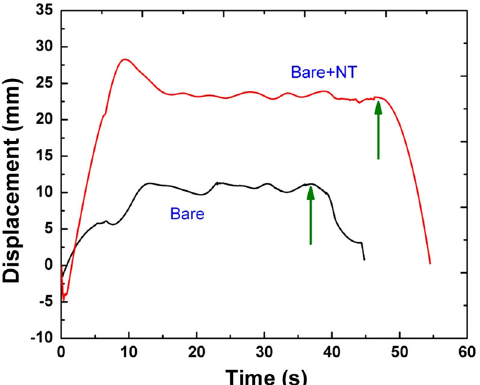
Fig. 2 Displacement of a single heater. The black line corresponds to the Bare heater and the red line — to the Bare+NT heater. Green arrows denote the moments when the heaters were turned